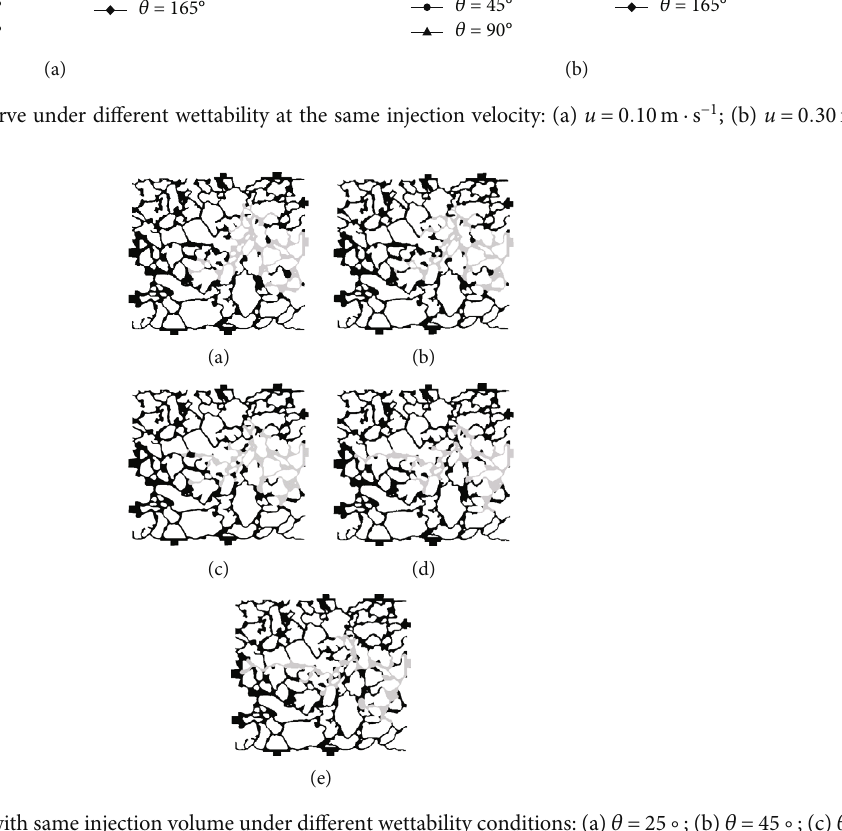
Figure 8: Oil-water distribution with same injection volume under di ff erent wettability conditions: (a) θ = 25 ° ; (b) θ = 45 ° ; (c) θ = 90 ° ; (d) θ = 125 ° ; (e) θ = 165 °